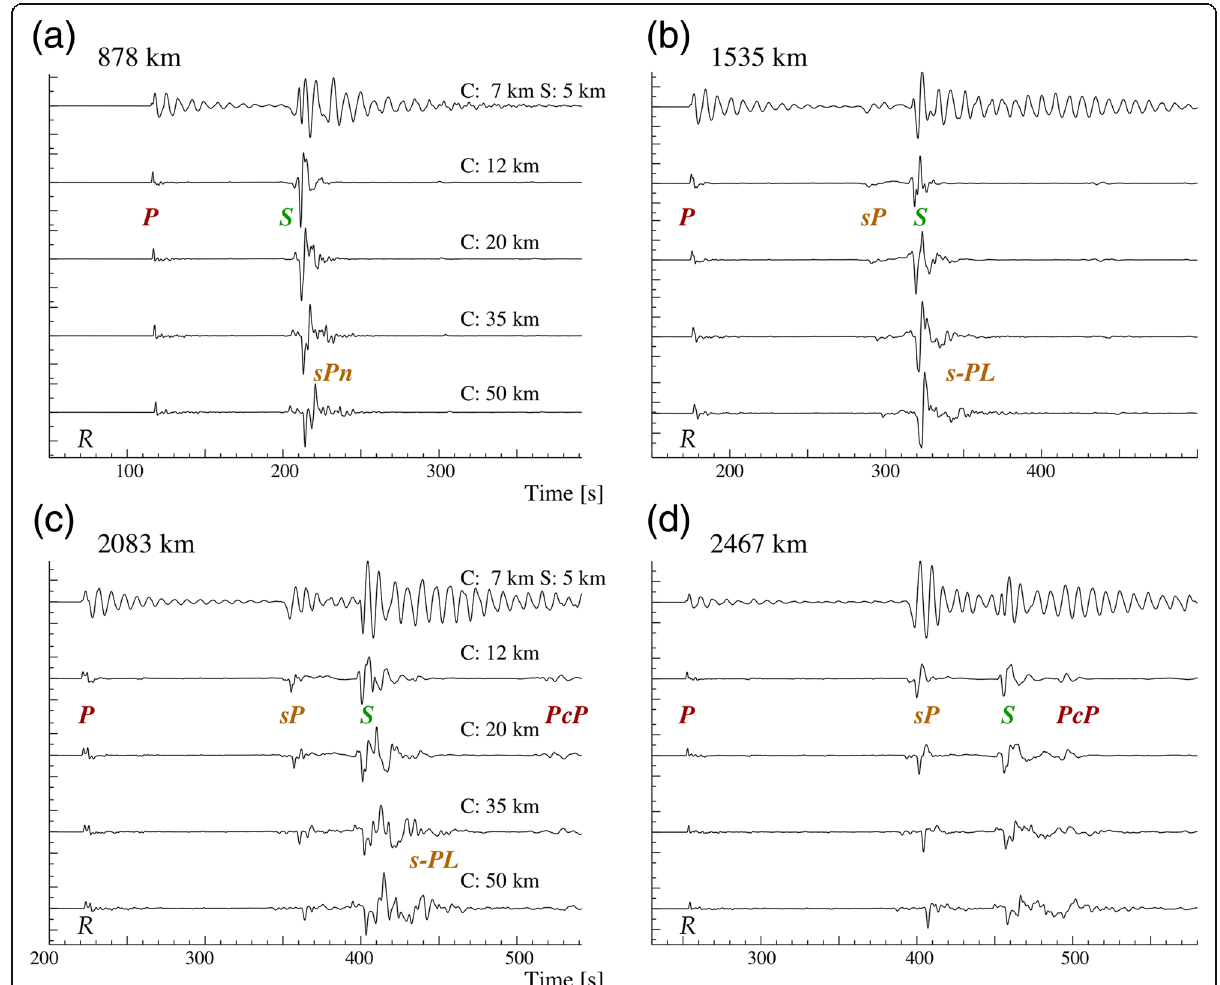
Fig. 4 Comparison of synthetic waveforms for the R component of ground velocity for a 600-km-deep source, for modifications of the ak135 model with varying near surface structure. The top trace includes 5 km of sea water on top of a 7 km crust with recording at the seabed, and the other traces represent progressively thickening continental crust up to 50 km thickness. Four epicentral distances are shown: a 878 km (7.89°) where the P and S phases are produced solely by upgoing waves, b 1535 km (13.80°) where there is interference between waves that have left the source both upwards and downwards to produce more complex waveforms, c 2083 km (18.73°) where sP becomes a distinct phase and d 2467 km (22.19°) where sP is as large as or larger than the S phase. At the larger distances, there is a clear separation of converted